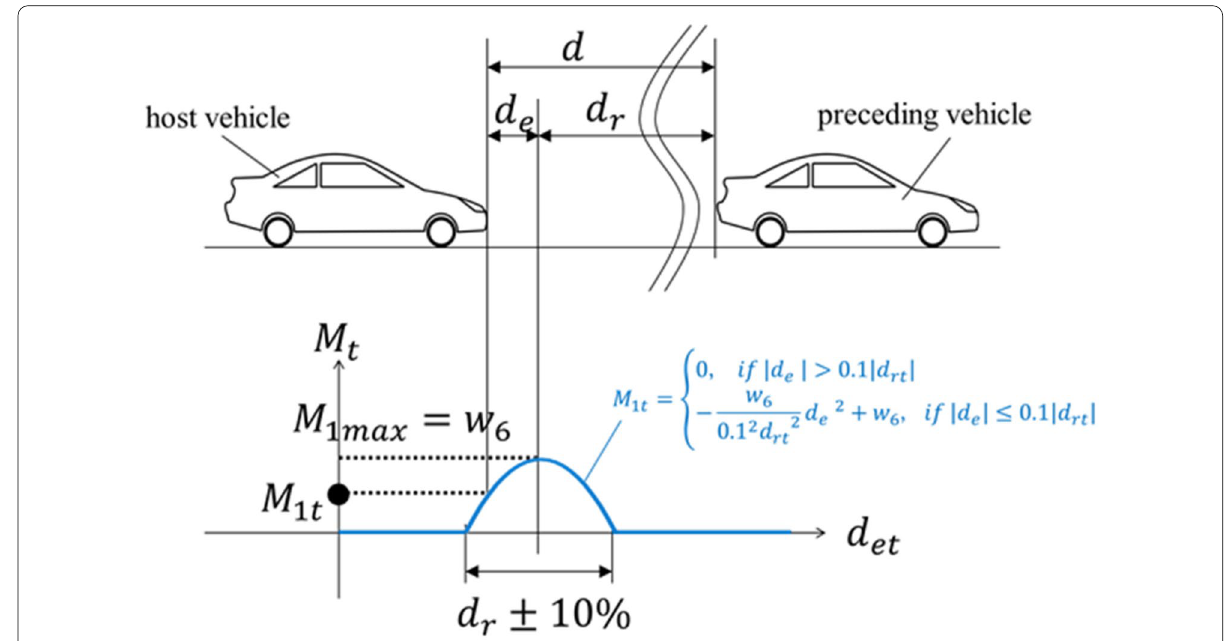
Fig. 3 Logic of the reward value M 1 t ( d > d r )